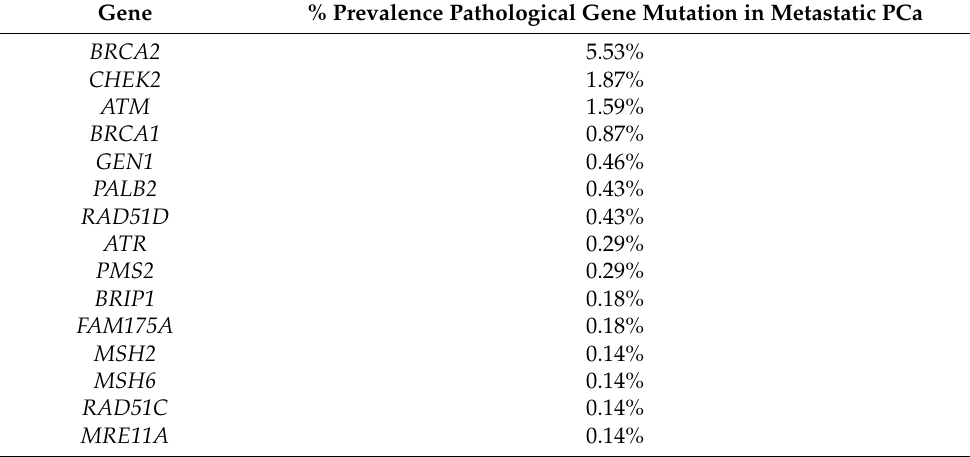
Table 1. List of identified germline genes that have been implications in advanced prostate cancer from seminal work from Pritchard et al. [11]. Gene % Prevalence Pathological Gene Mutation in Metastatic PCa BRCA2